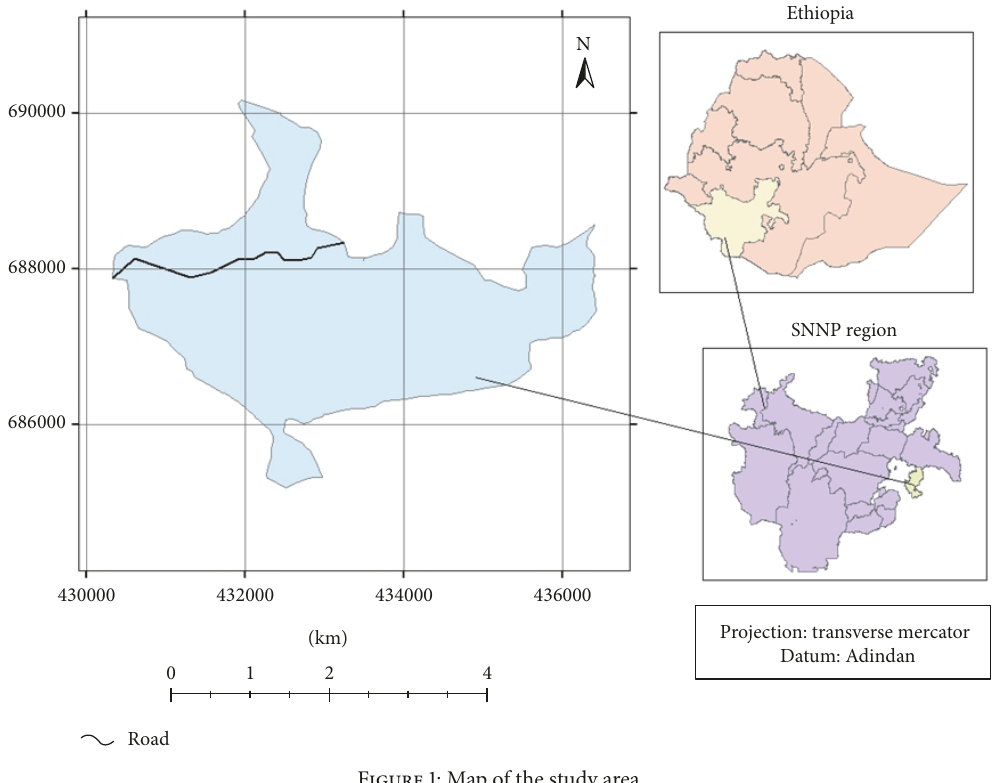
Figure 1: Map of the study area.